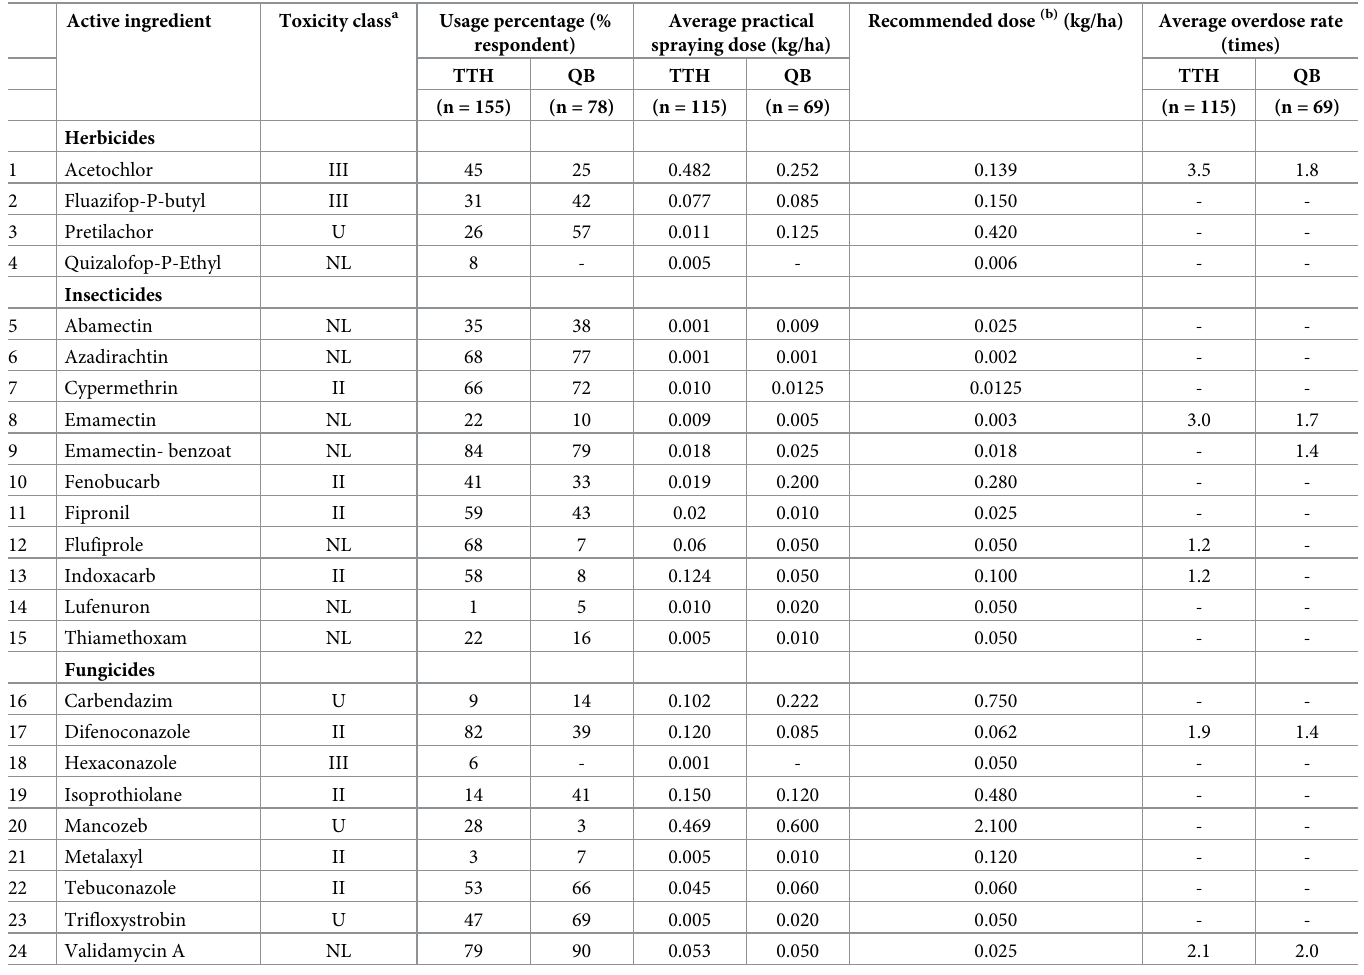
Table 1. Pesticice usage and overdose rate at the study